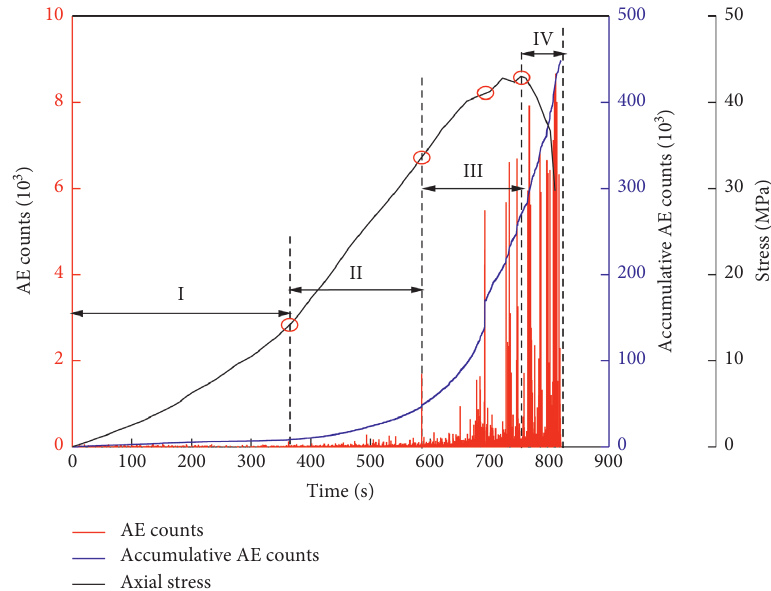
Figure 7: AE counts and accumulative AE counts of the jointed specimens with α � 0 ° .